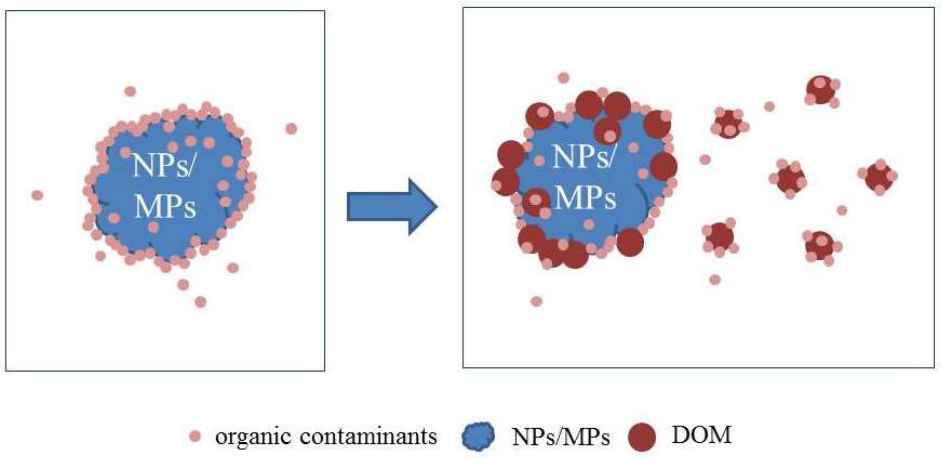
Figure 2. The sorption behavior of organic contaminants to NPs/MPs in the presence of dissolved organic matter (DOM).